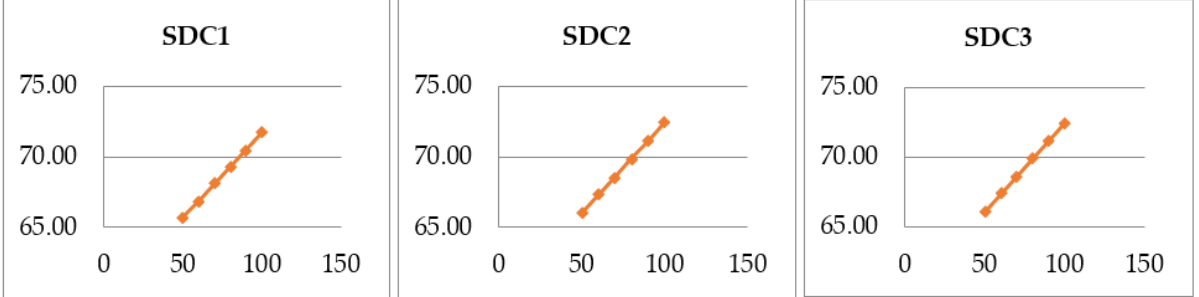
Figure 2. Farrowing rate (%) depending on the motility (%) nested within the sperm count in a dose (SDC1: ≤ 2.50 × 10 9 ; SDC2: 2.51–4.00 × 10 9 ; SDC3: ≥ 4.01 × 10 9 ).